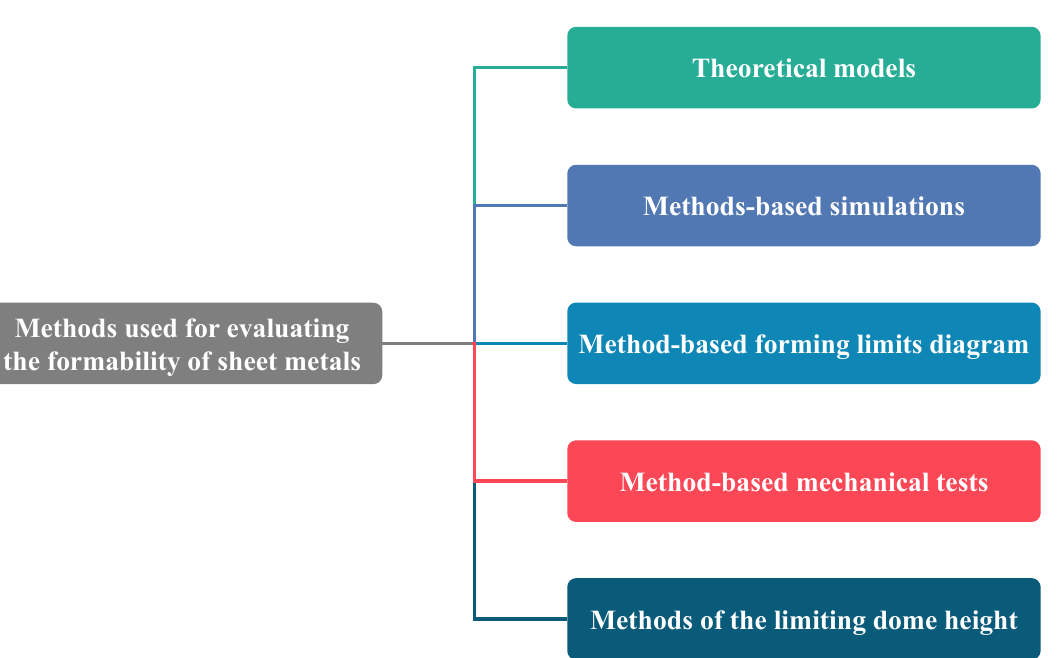
Figure 27. Methods used to evaluate the formability of sheet metals.